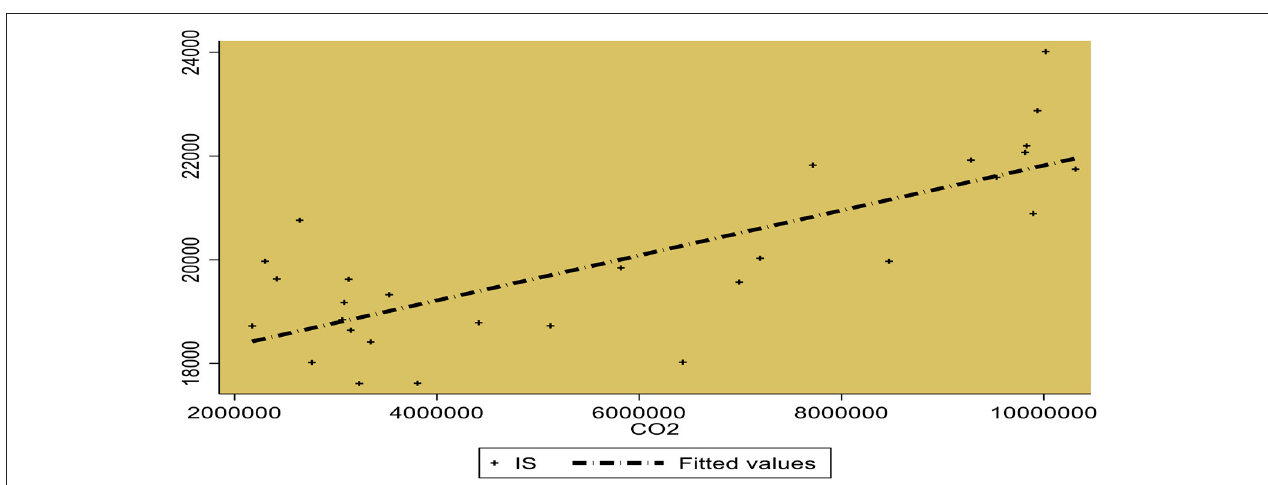
FIGURE 2 | Scatterplots of industrial structure vs. CO 2